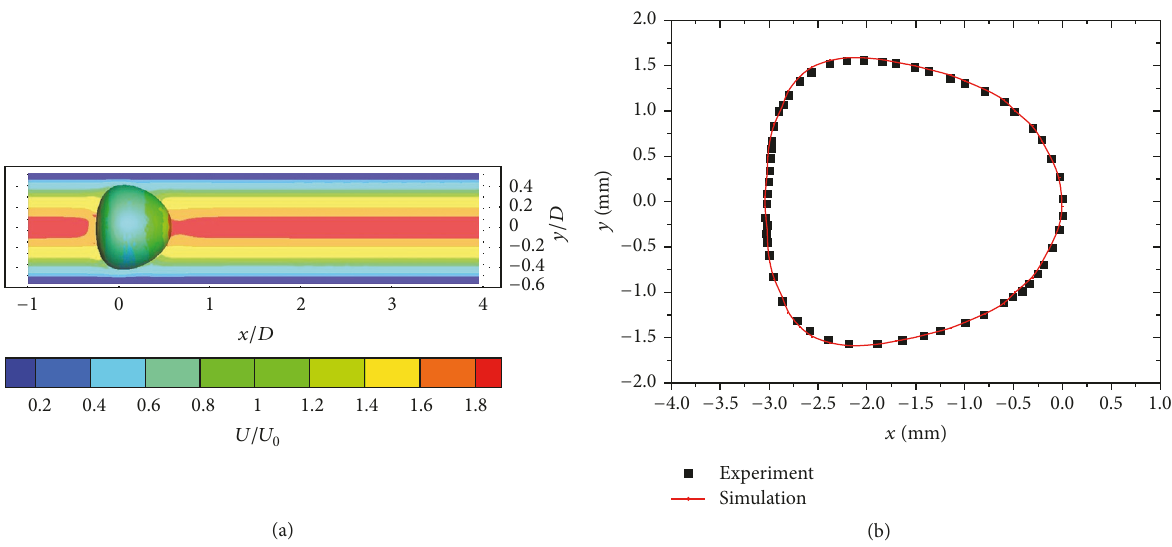
Figure 3: Simulation of a capsule passing through a microchannel: (a) contour of streamwise flow velocity ( 𝑈 is normalized with the mean velocity 𝑈 0 , and the coordinates are normalized with tube diameter 𝐷 ) and (b) comparison of the capsule deformation against experimental data [15].